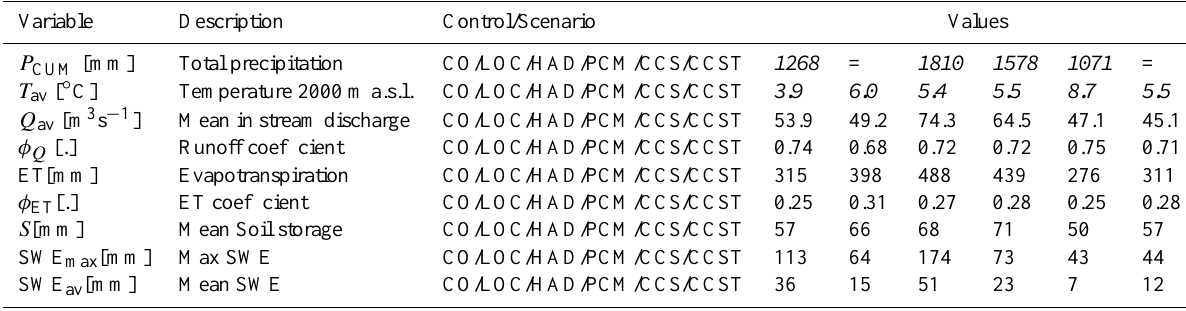
Table 4. Oglio at Sarnico. Most relevant hydrological features (yearly values). Control run 1990–1999 and scenarios, 2045–2054. Sym- bol=indicates a value taken as equal to value at its left. In italics are values taken from GCMs and observations; normal font values are outputs from the hydrological model. Values in mm are weighted average upon altitude belts. Runoff and evapotranspiration coefficients are with respect to total precipitation.